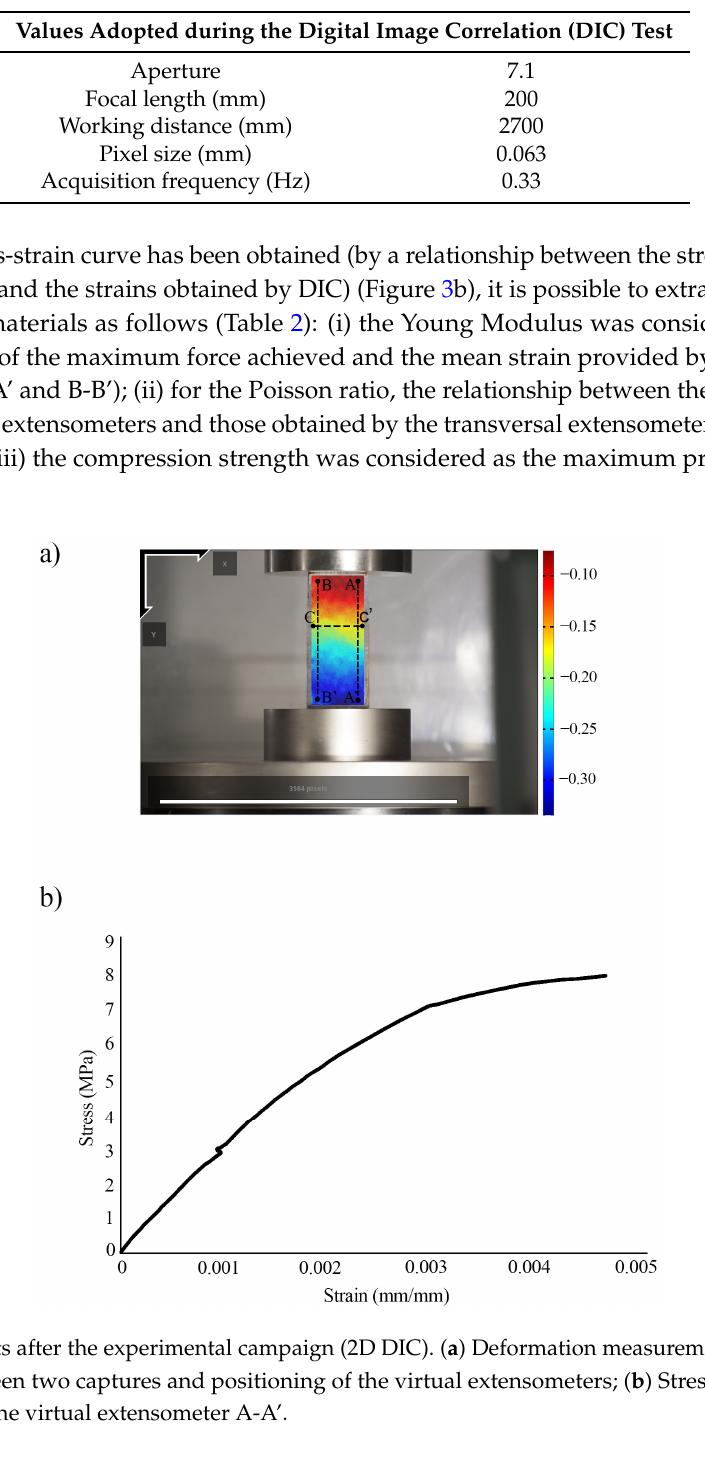
Table 1. Summary of the different properties set during the Digital Image Correlation (DIC) test carried out with a Canon EOS 500D and a macrolens system 70–300 mm.